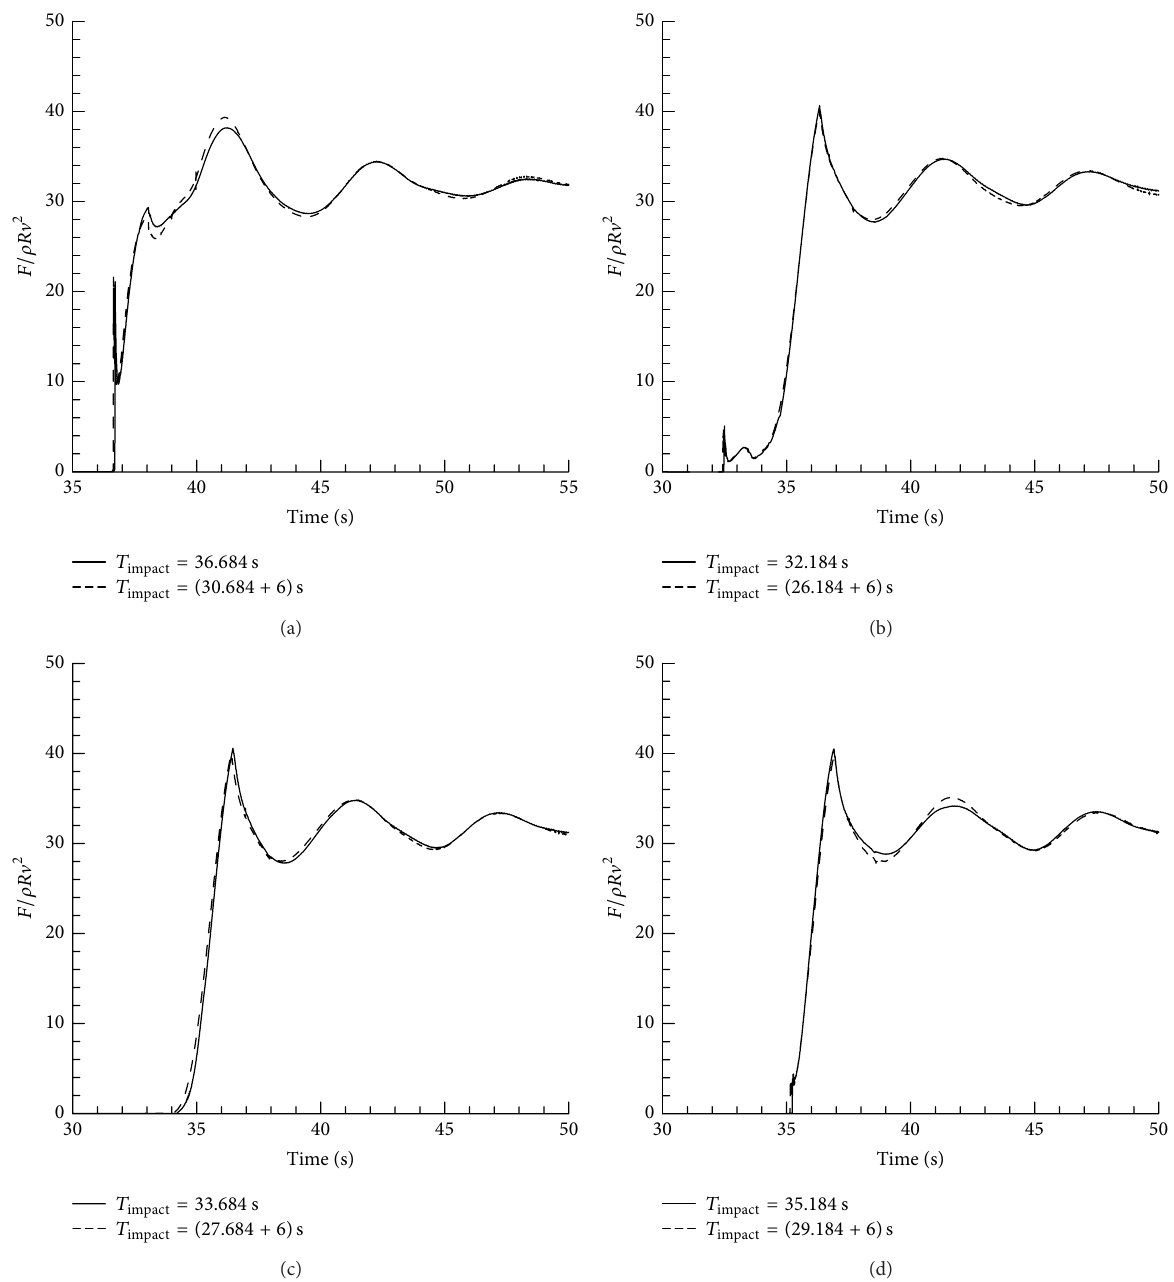
Figure 10: Time history of hydrodynamic force with different impact phase angles: (a) 0 ∘ ; (b) 90 ∘ ; (c) 180 ∘ ; (d) 270 ∘ .